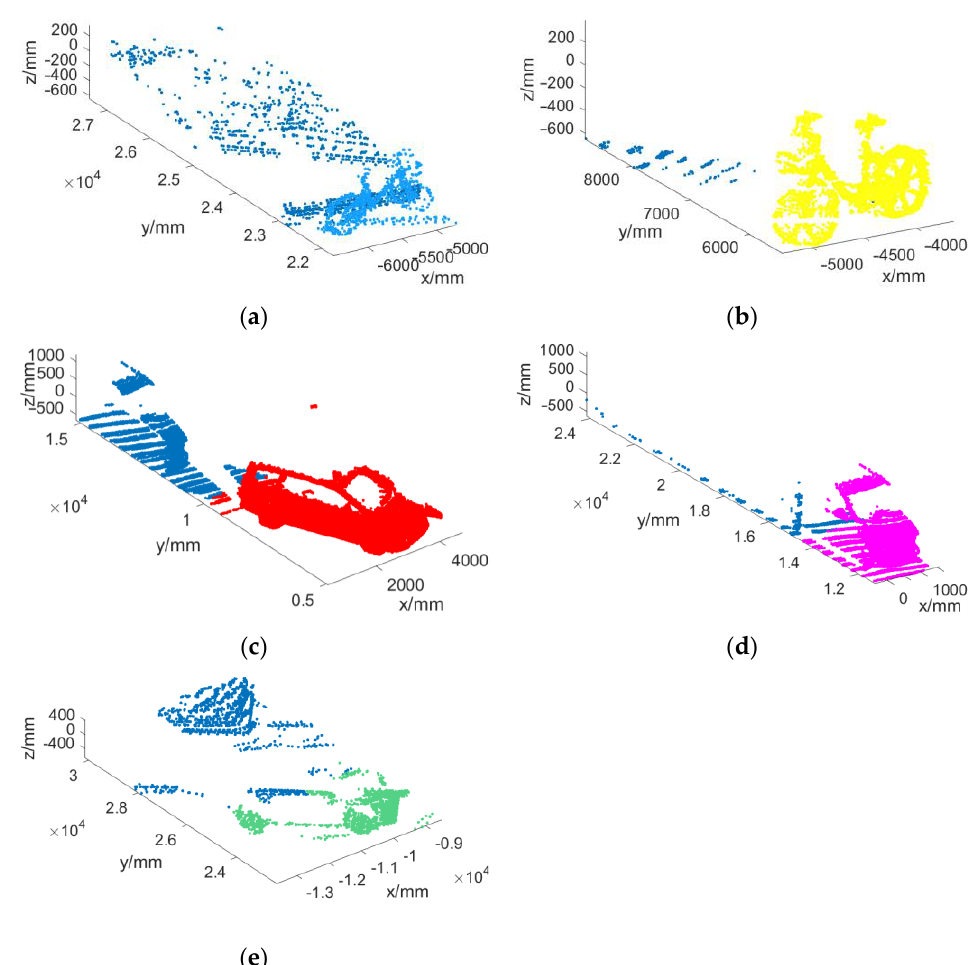
Figure 27. The ANFIS results in the outdoor test scene: ( a – e ) the ANFIS results of recognized targets with the same mask color in Figure 26. Table 11. Localization error statistics in the outdoor test